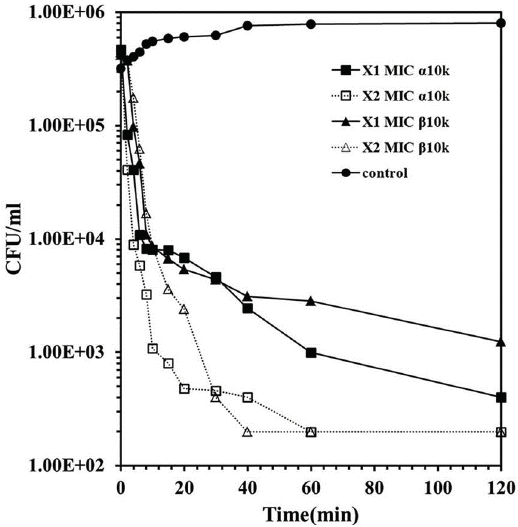
Figure 2. Time-kill kinetic of α -chitosan and β -chitosan samples in E. coli O157. Bacterial cells were exposed to samples at one or two times concentration of their minimum inhibitory concentration (MIC) values in pH 7.4 and incubated for 0–120 min.